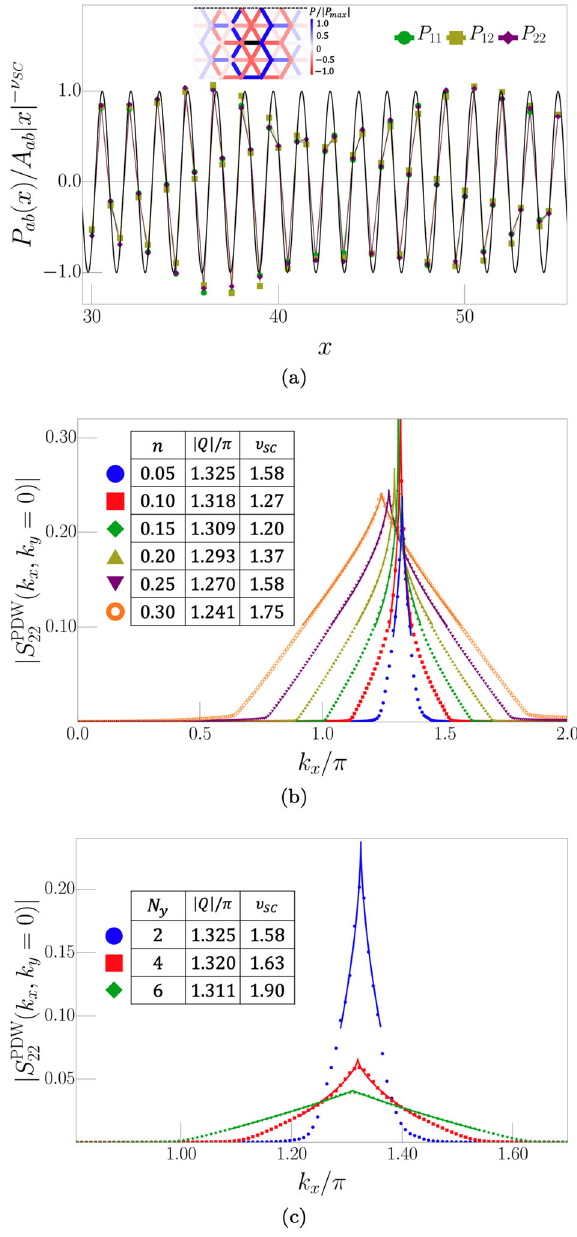
Fig. 2 Pair-density-wave correlations. a The pair-pair correlator normalized by a power-law decay function A ab x (cid:2) ν SC with ν SC = 1.20 for a two-leg cylinder of length N x = 240 and electron density n = 0.15. The black reference curve is cos ð Qx þ ϕ SC Þ with Q = 1.309 π extracted from the structure factor. The inset shows the short-distance pair correlation pattern around the center of a four-leg cylinder of length N x = 100 and electron density n = 0.15 with the reference bond colored in black. ð k x ; k y ¼ 0 Þ at various electron b Magnitude of structure factor S PDW 22 densities on the two-leg cylinder of length N x = 240. The interval k x ∈ ( − 2 π , 0) mirrors the range shown. The fi tted curves with functional form A (cid:2) B j k x (cid:2) Q j ν SC (cid:2) 1 are plotted as solid lines with the same color for each fi lling, and the fi tted peak positions Q and exponents ν SC are listed. c Magnitude of structure factor for two-, four-, and six-leg cylinders with = 240, 100, n = 0.05 and correspondingly N x